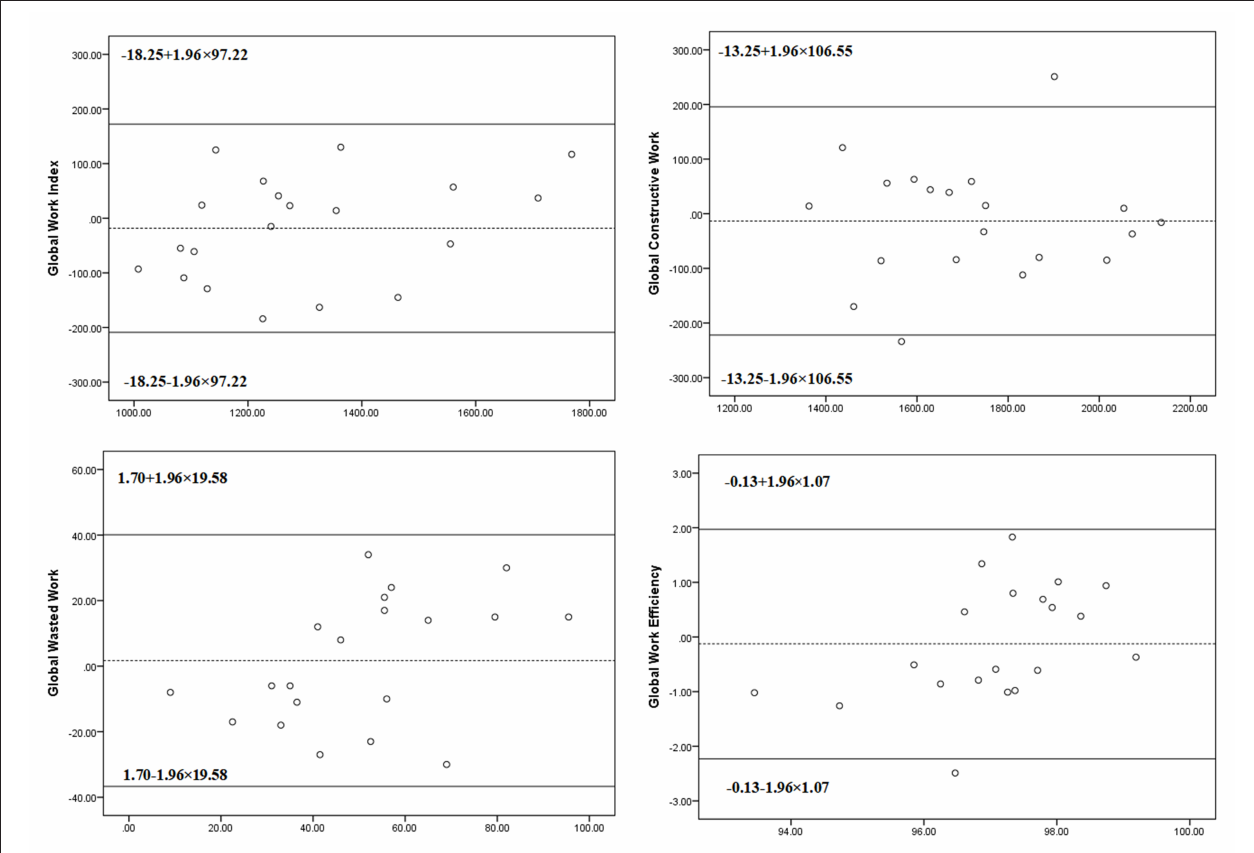
FIGURE 5 | The Bland–Altman analysis for assessing inter-observer variability of global work index, global constructive work, global wasted work, and global work efficiency. Lines represent bias and 95% limits of agreement for measurements performed in 20